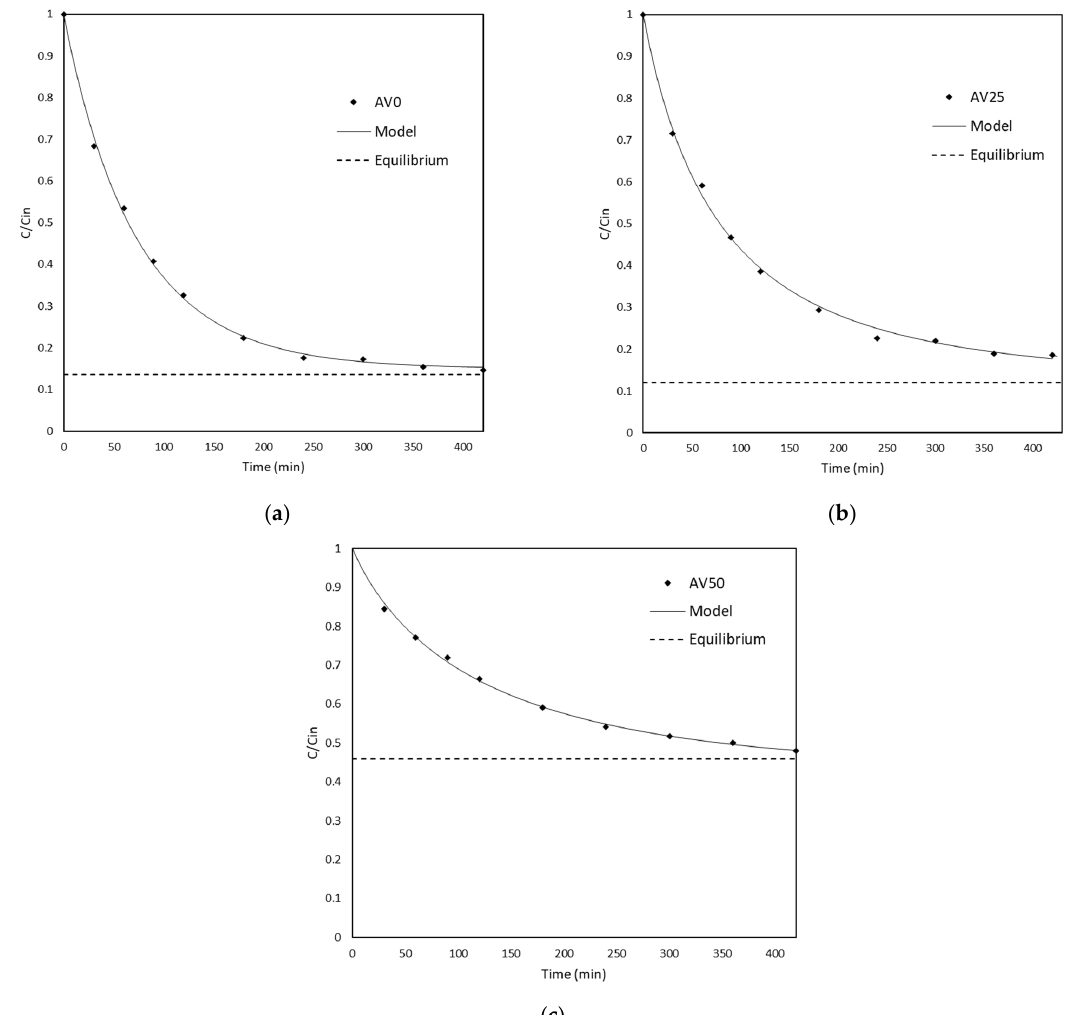
Figure 9. Experimental kinetic data for ( a ) AV0, ( b ) AV25, and ( c ) AV50 reported as the ratio between the concentration of Methylene Blue in water and its initial concentration (C/Cin) versus time. The solid line represents the model prediction, while the dotted line is the expected equilibrium threshold. The values of 𝑘 (cid:3013) 𝑎 and 𝐷 (cid:3032)(cid:3033)(cid:3033),(cid:3014)(cid:3003) .derived from fitting are reported in Table 5. As ex- pected, the 𝑘 (cid:3013) 𝑎 calculated for AV0, AV25, and AV50 are of the same order of magnitude since the fluid dynamic conditions set in each test were the same. In particular, the 𝑘 (cid:3013) 𝑎 estimated for AV0 is 7.6% smaller than the one obtained for AV25 and 62.5% higher than the one obtained for AV50. This result could be attributed to some oscillation of the aver- age particle size, which in the model was chosen to be 0.75 mm, but that can be included in the range of 0.5–1 mm (as explained in the Materials and methods section) or by the lack of setting perfectly the same agitation speed for each test.